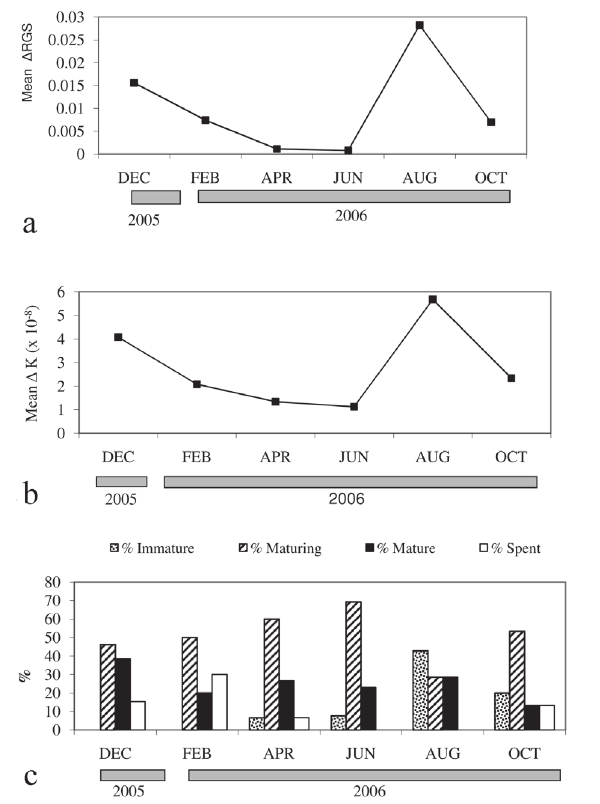
Fig. 4. Mean values of Δ RGS ( a ) and Δ K ( b ) and frequency of bi-monthly percentage of the maturational stages for the females ( c ) of Plagioscion magdalenae in the bay of